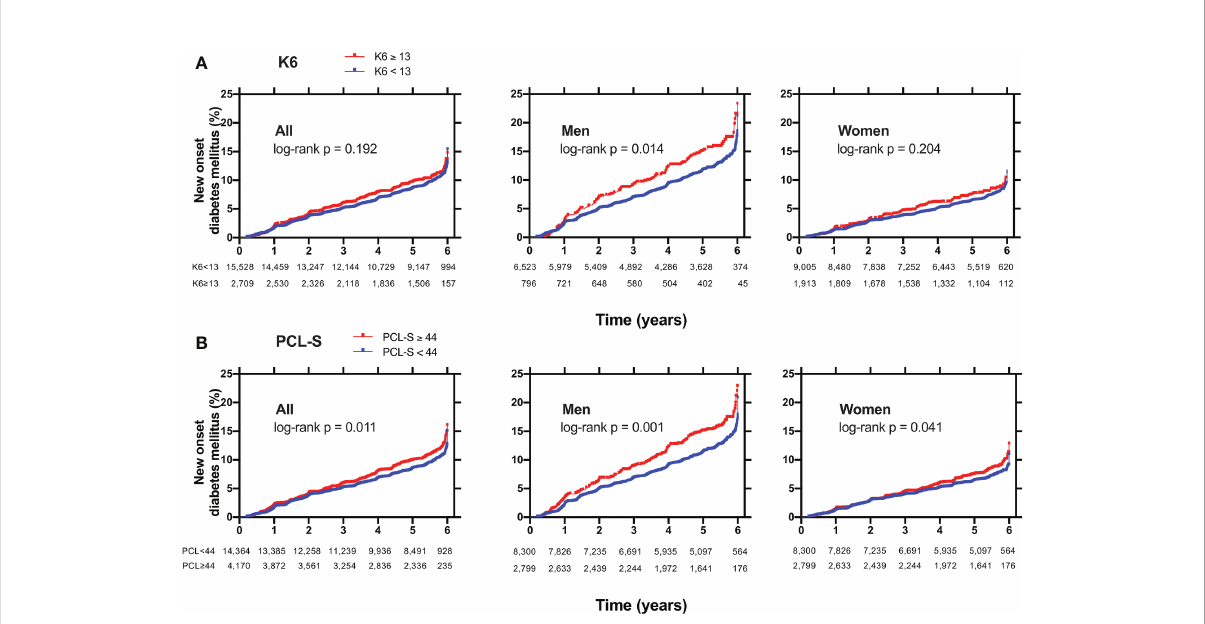
FIGURE 3 Kaplan Meier curves for new-onset diabetes mellitus in (A) participants with K6 < 13 (blue lines) or with K6 ≥ 13 (red lines) or in (B) participants with PCL-S < 44 (blue lines) or with PCL-S ≥ 44 (red lines). Non-diabetic participants were plotted for new-onset diabetes mellitus in all, men, and women. K6: Kessler 6, PCL-S: PTSD Checklist Stressor-Speci fi c Version; DM: diabetes mellitus; P: p values calculated by log-rank